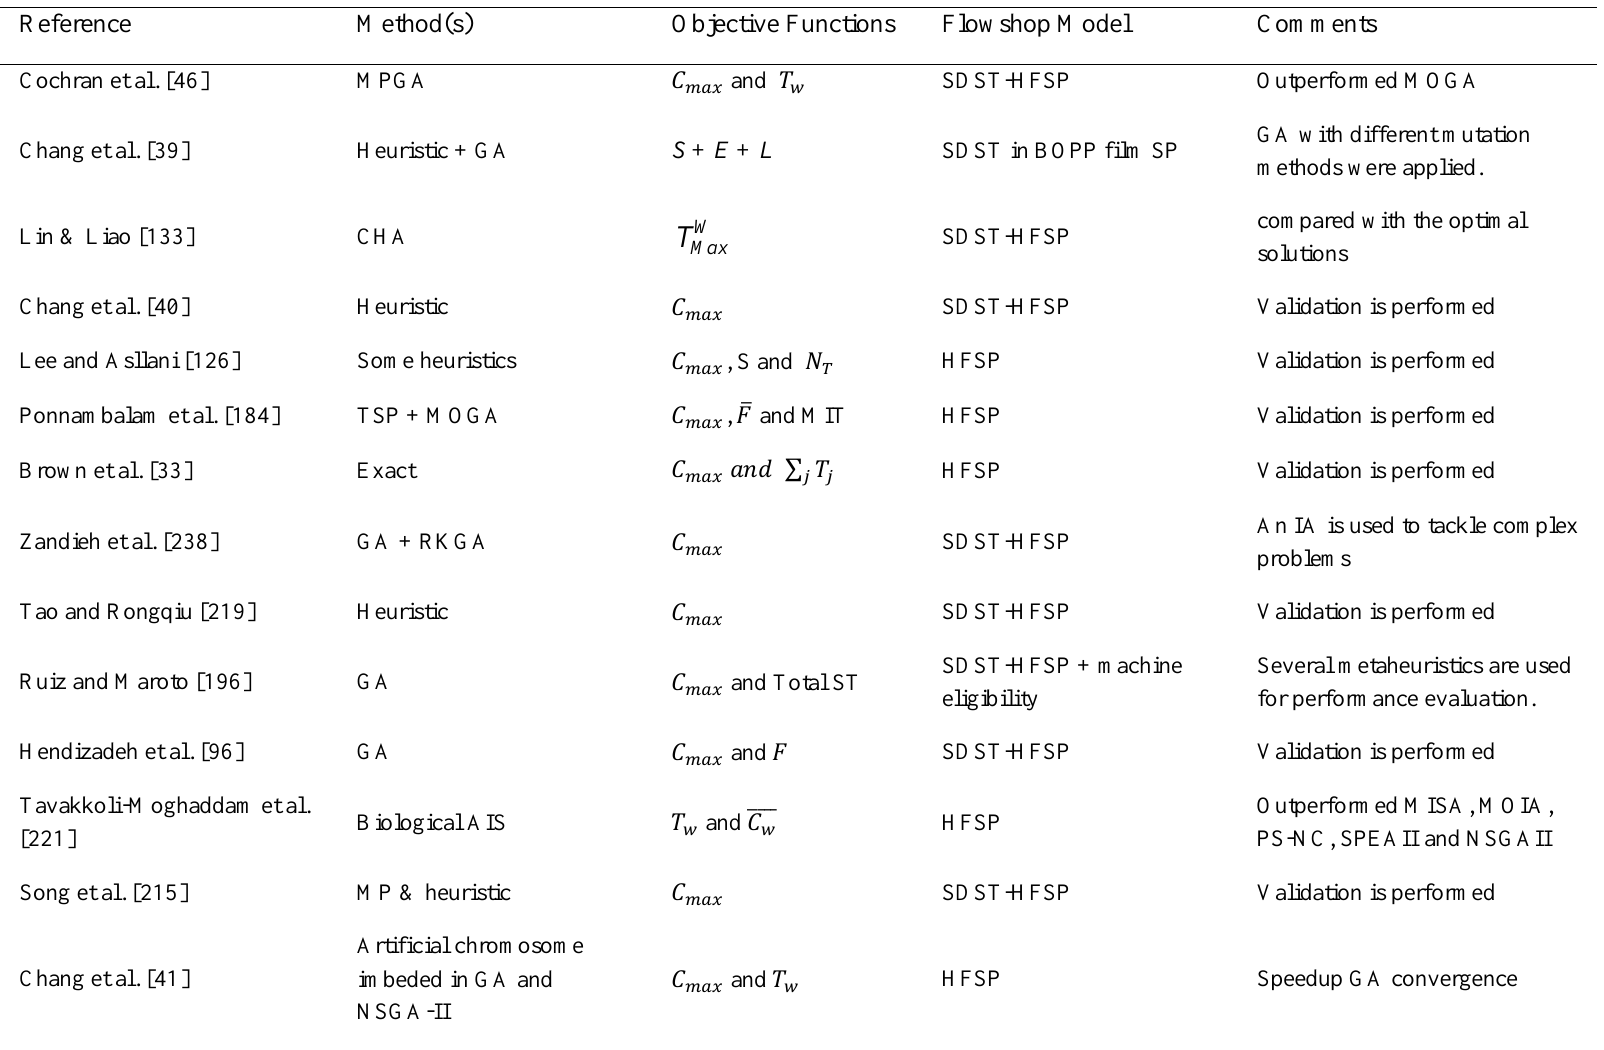
Table 3. A Consolidated Review of